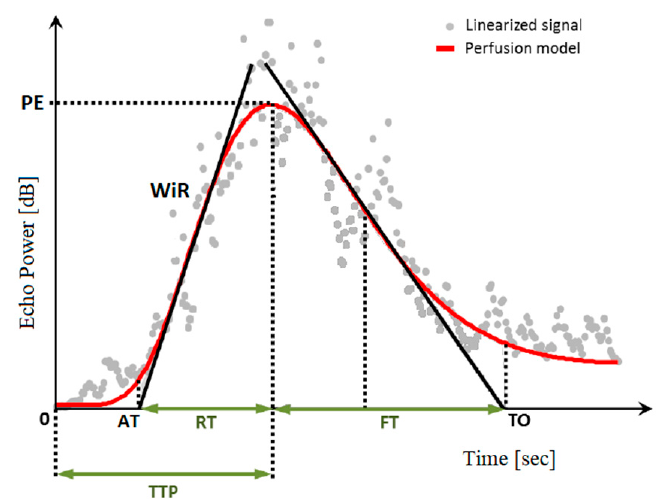
Figure 1. Examples of time–intensity curve explaining how peak enhancement (PE), wash-in rate (WiR), arrival time (AT), rising time (RT), time to peak (TTP), falling time (FT) and time to fall (TO) were calculated.